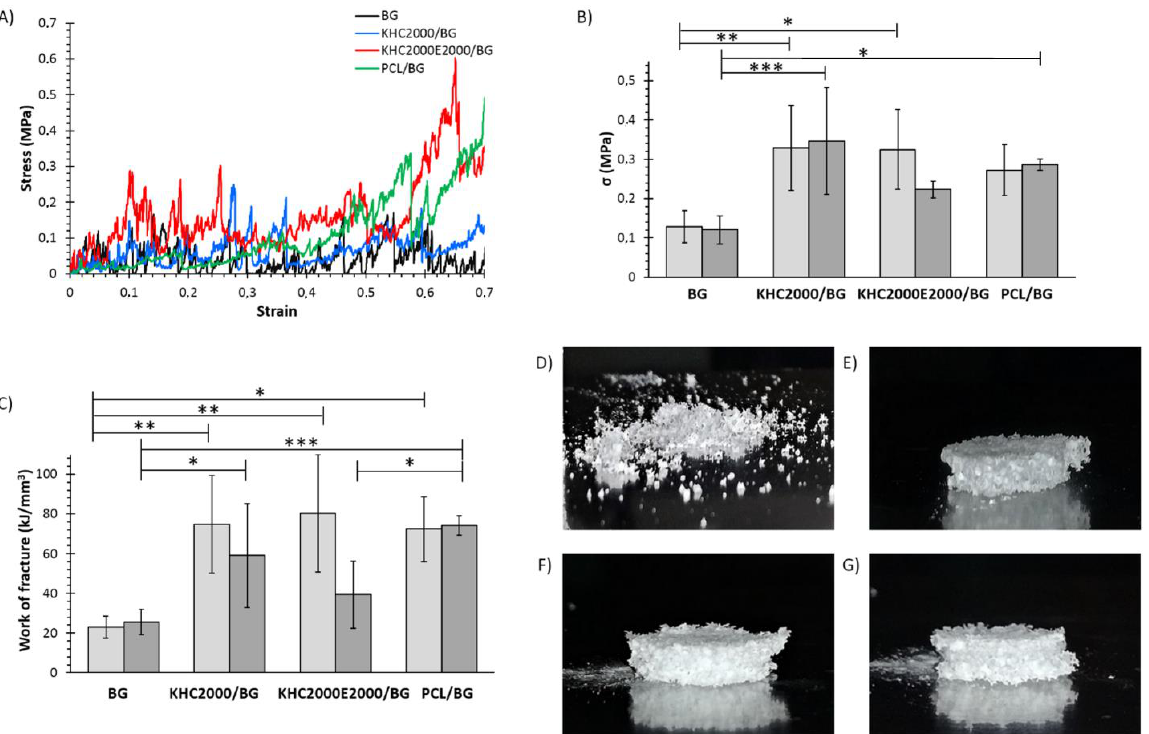
Figure 11. Mechanical characterization of the developed scaffolds. ( A ) Representative compressive stress-strain curves of BG, KHC2000/BG, KHC2000E2000/BG, and PCL/BG scaffolds, ( B ) compres- sive strength and ( C ) work of fracture of BG, KHC2000/BG, KHC2000E2000/BG, and PCL/BG scaf- folds evaluated in dry (light gray) and wet (gray) conditions. The appearance of ( D ) BG, ( E ) PCL/BG, ( F ) KHC2000/BG, and ( G ) KHC2000E2000/BG scaffolds after compression test. * 0.01 < p < 0.05, ** 0.001 < p < 0.01, and *** 0.0001 < p <